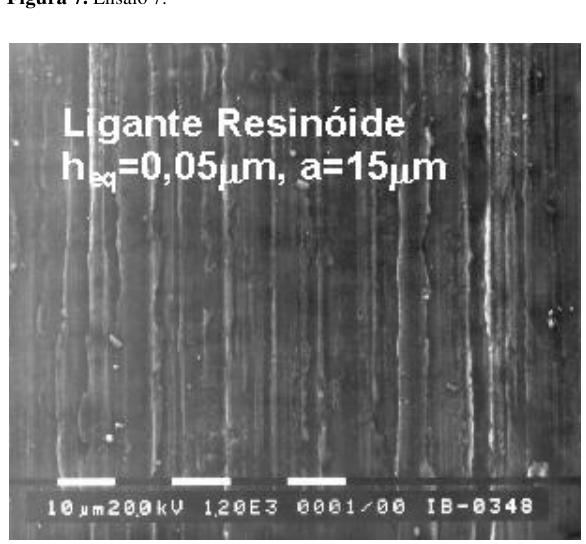
Figura 8. Ensaio